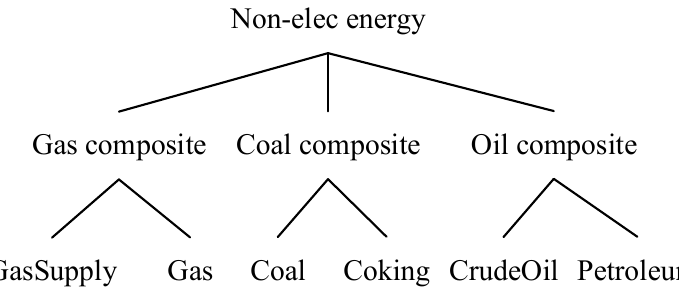
Figure 3. The nesting structure of non-electricity energy used by producing sectors.